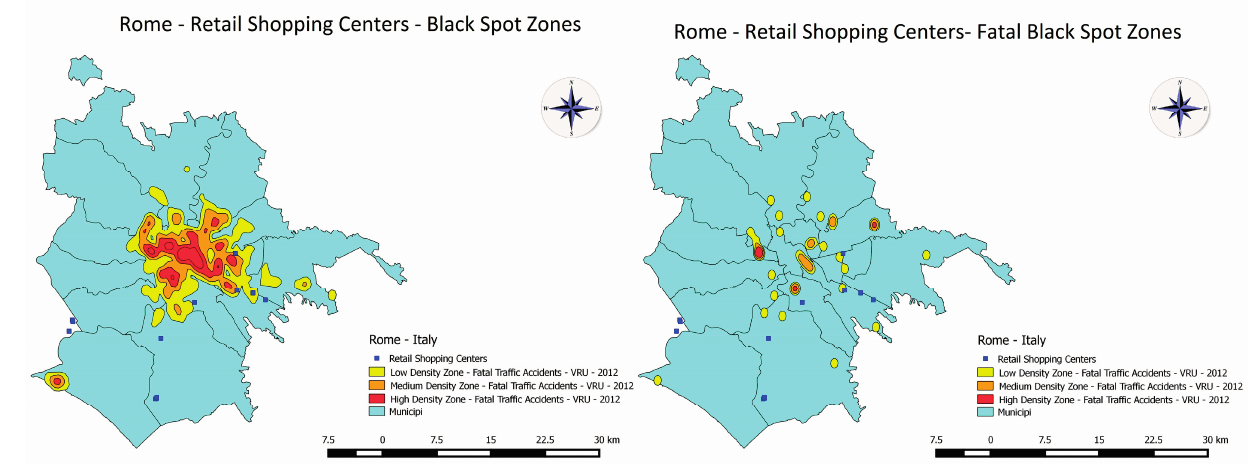
Figure 14. Retail shopping centers/black spots: Rome.